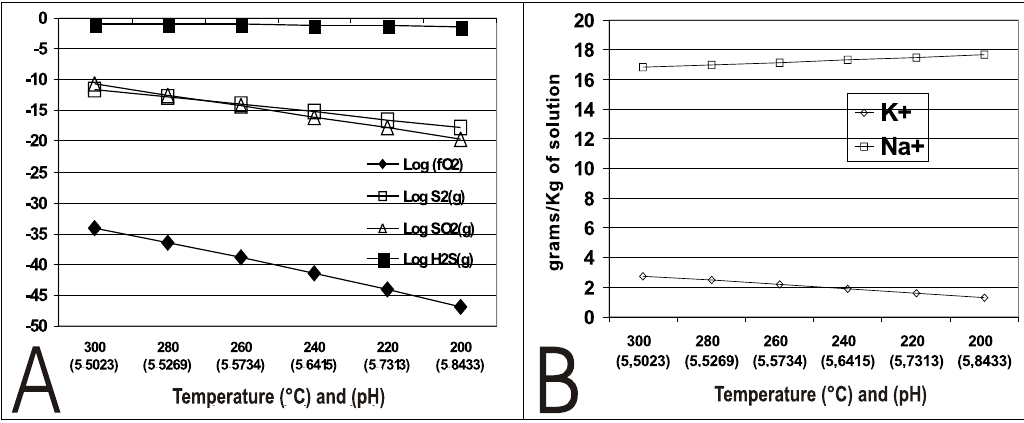
Fig. 3 – Evolution of thefluids components in contact with the mineral paragenesis as a function of temperature decrease from 300 ◦ C to 200 ◦ C. The pH of the solution is shown in parenthesis. A – Log f O 2 , Log S 2 (g), Log SO 2 (g) and Log H 2 S. B - Concentrations in g/Kg in K + and Na +